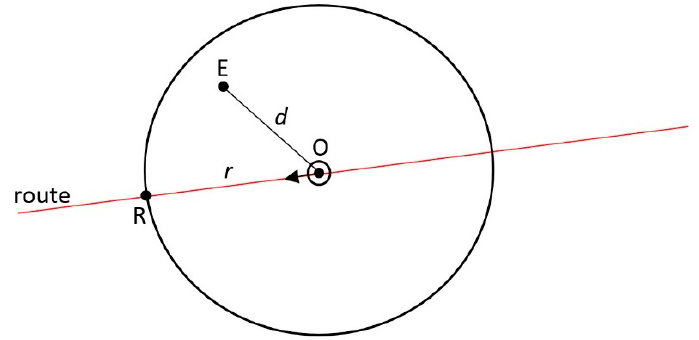
Figure 6. Return to the set route (O—point indicating the current position of the ship, E—point corresponding to the target vertex, R—point defining the return to the set route).